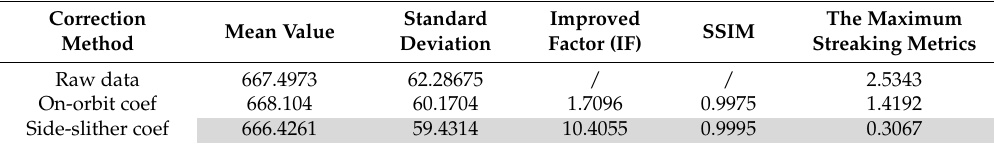
Table 5. Comparison of quantitative values of the desert images.